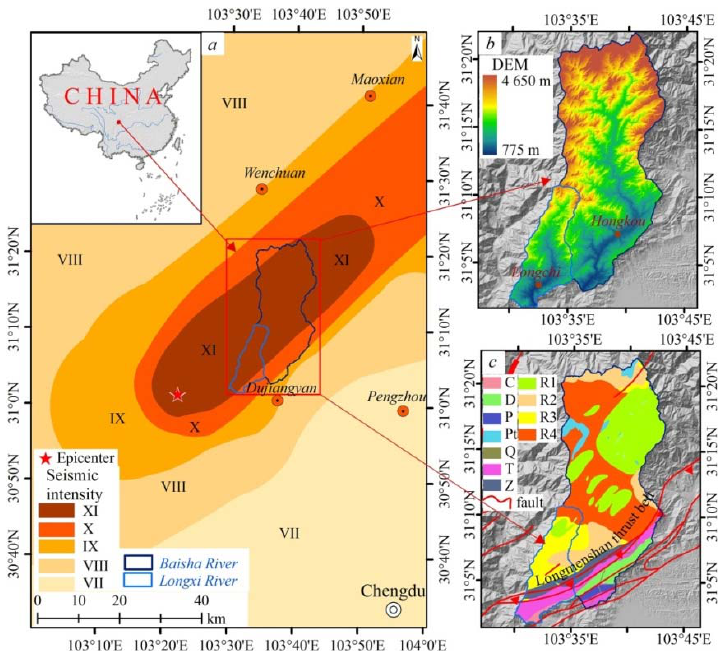
Figure 1. ( a ) Study area and Wenchuan earthquake seismic intensity map; ( b ) digital Elevation Models (DEM) map of the study area; ( c ) simplified geological map of the study